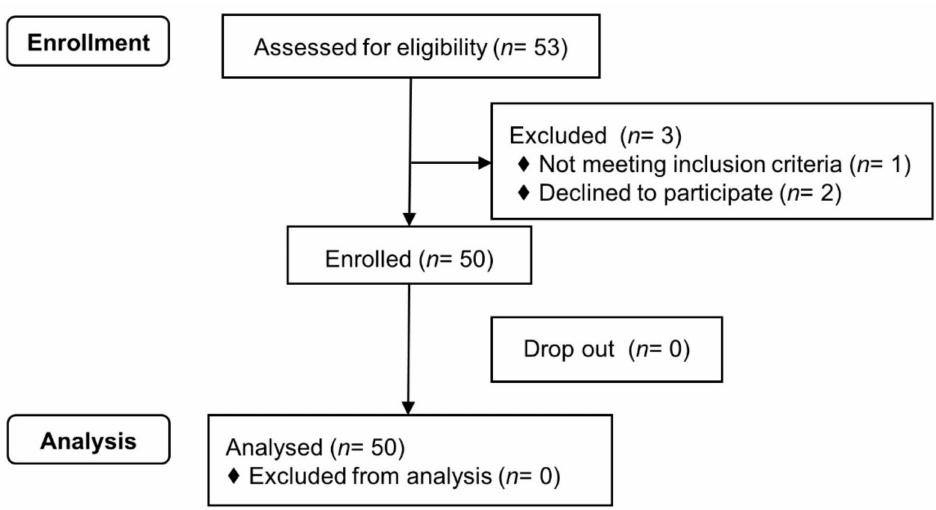
Figure 1. Flowchart of study patient